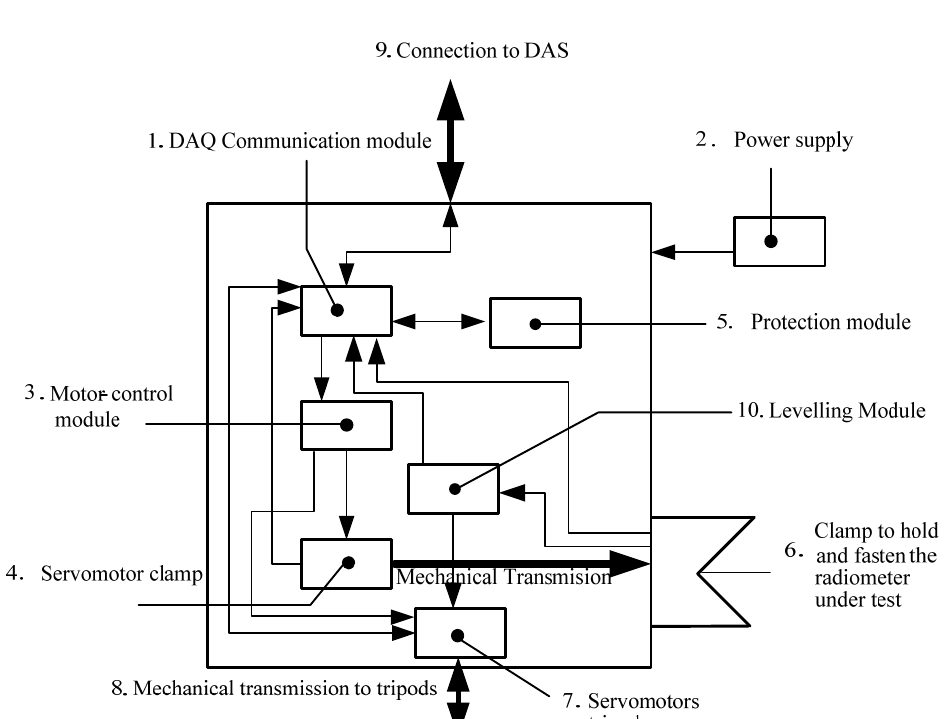
Figure 2. Block diagram of the automatic